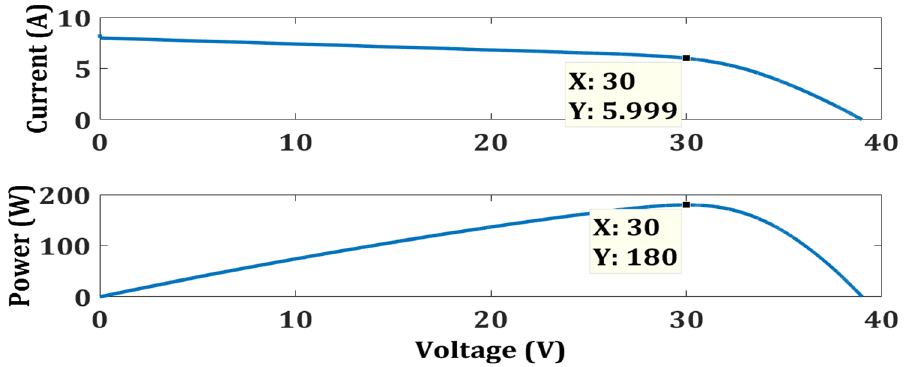
Figure 25. Characteristic curves of 3S2P PV system for test case 1.